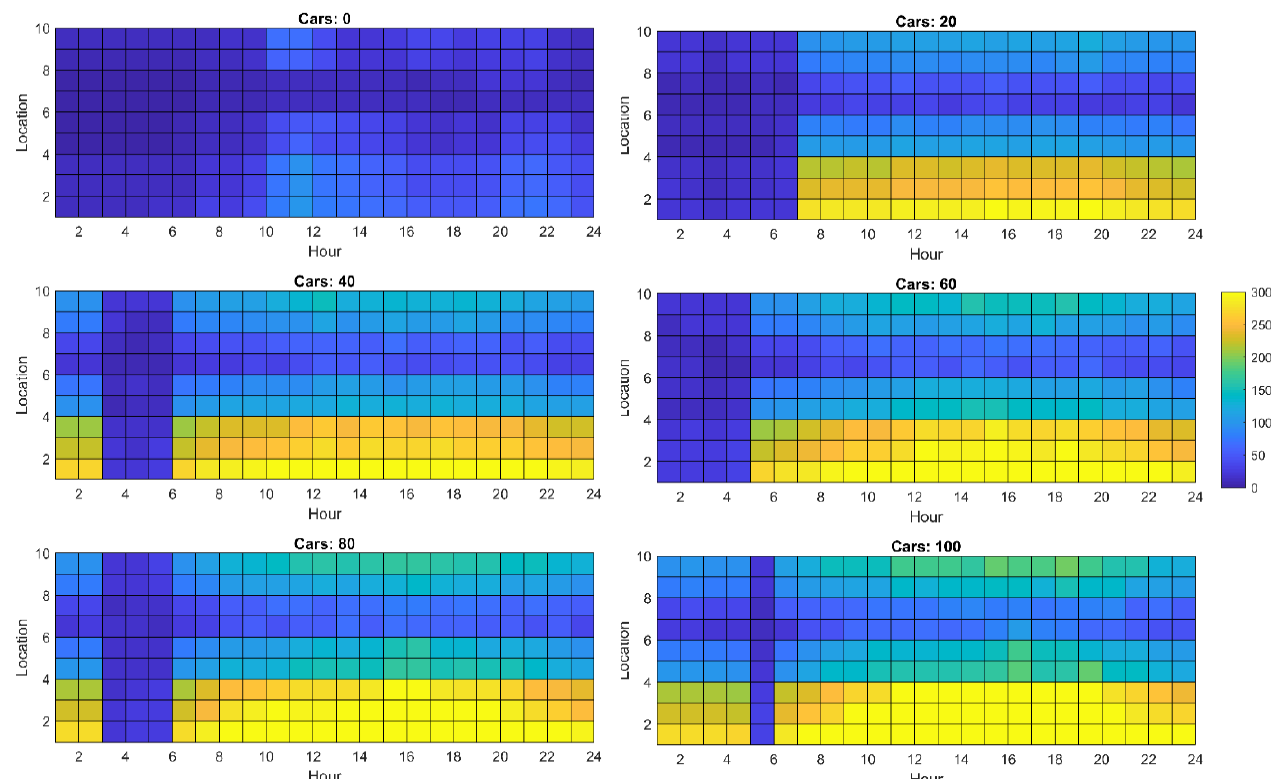
Figure A1. Maximum line loading (percentage) observed in network 1.